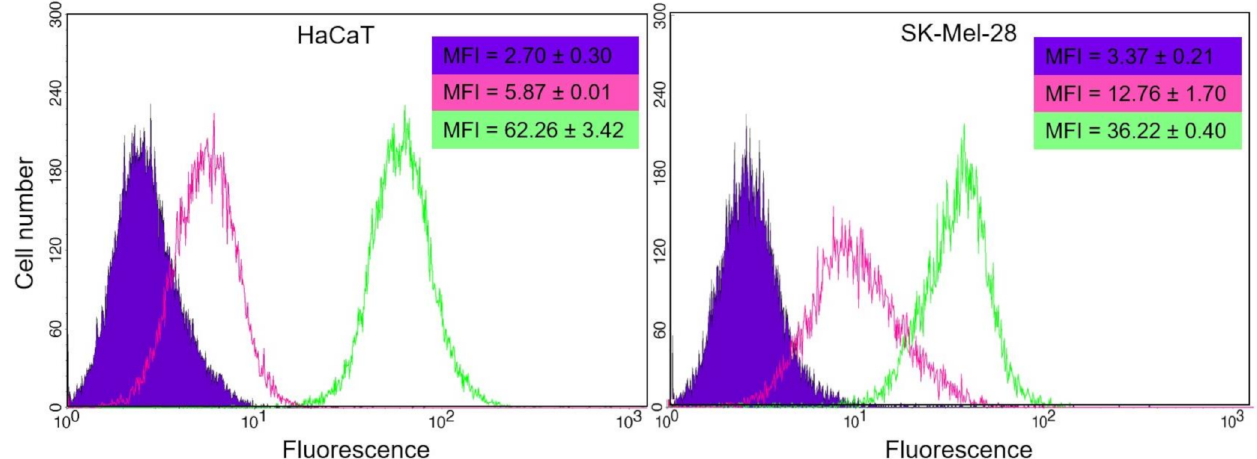
Figure 8. Histograms for ( HaCaT ) and ( SK-Mel-28 ) were obtained by flow cytometry after incubation at 37 ◦ C (green) and 4 ◦ C (pink) with F-UDL-Vis for 4 h for HaCaT and 1 h for SK- Mel-28. The untreated control is shown in violet. The presented histograms correspond to one of the replicates, and the mean fluorescence intensity (MIF) ± SD values obtained are denoted following the same color code. MFI is shown as mean ± SD ( n = 2).